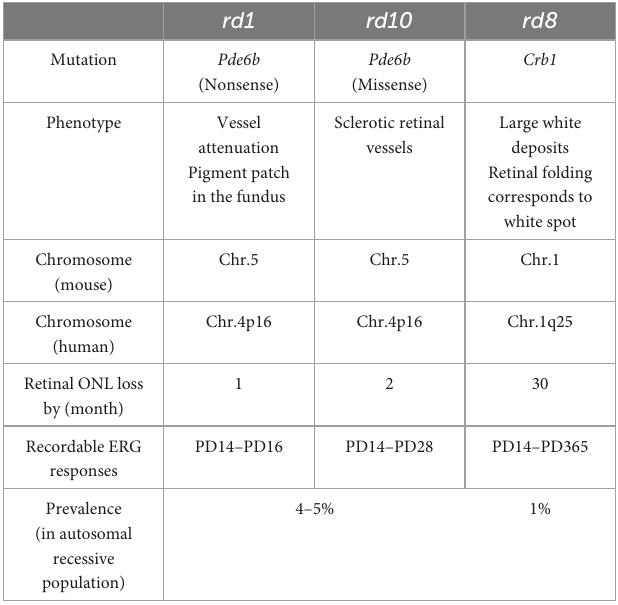
South Korea) and Young Bio (Seongnam, South Korea),